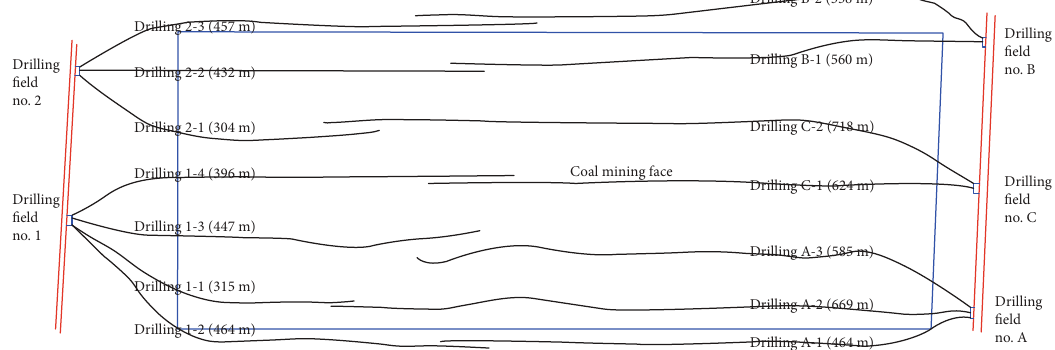
Figure 6: Plane fi gure of water pressure